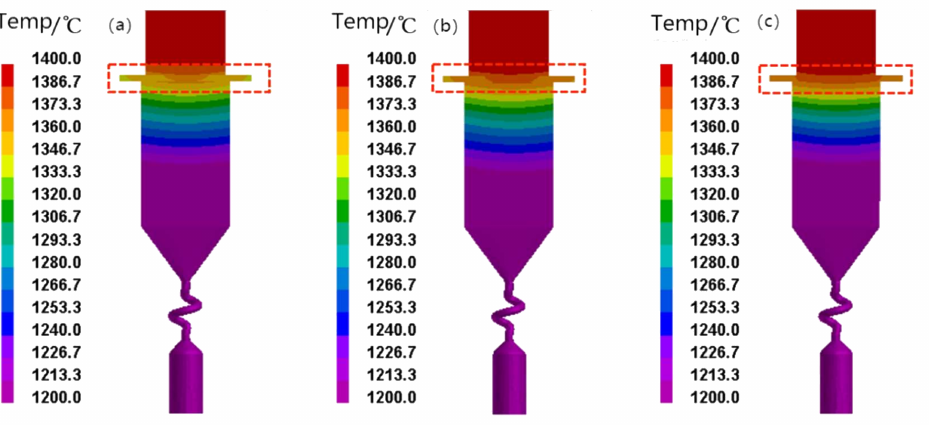
Figure 11. Temperature field with variable wall thickness mold: ( a ) wall thickness = 7 mm; ( b ) wall thickness = 10.5 mm; ( c ) wall thickness = 14 mm.